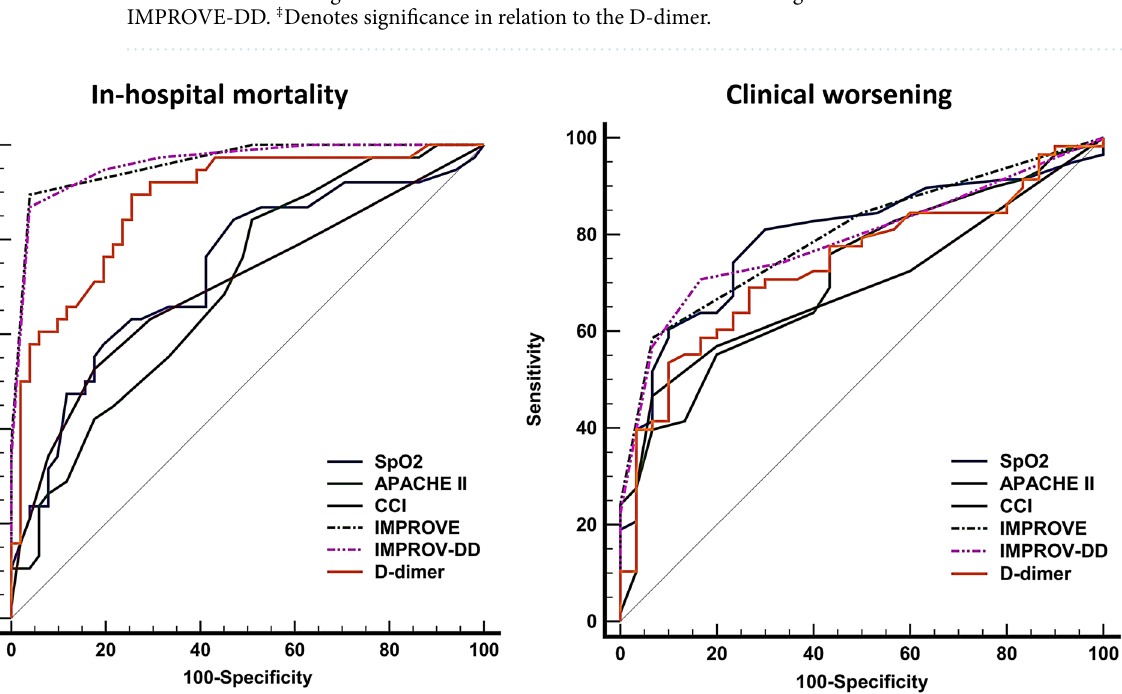
Figure 2. AUC analysis for the ability to predict in-hospital mortality (left) and clinical worsening (right). APACHE II acute physiology and chronic health evaluation II, CCI Charlson comorbidity index, DD D-dimer, IMPROVE international medical prevention registry on venous thromboembolism, SpO 2 peripheral oxygen